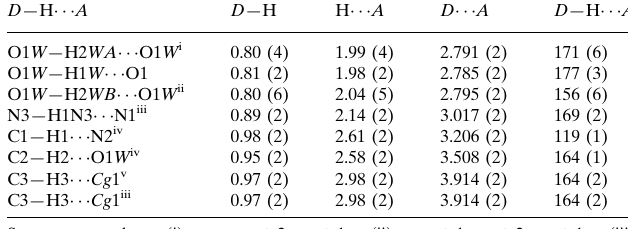
Hydrogen-bond geometry (A˚ , (cid:2) ). Cg 1 is the centroid of the benzene ring. D —H (cid:1)(cid:1)(cid:1) A D